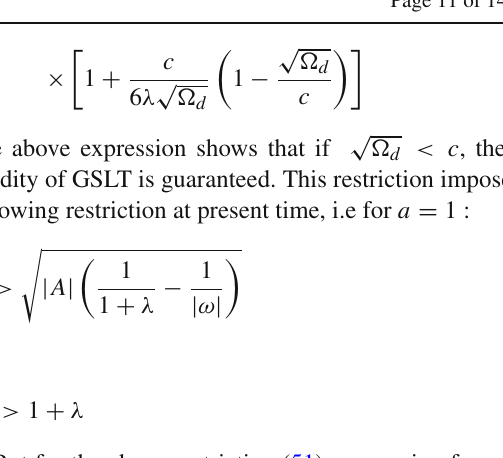
Fig. 5 Graphicalrepresentationof ˙ R A against a for ω = − 0 . 85 , A = 0 . 5, (cid:7) 0 = 0 . 623 and different